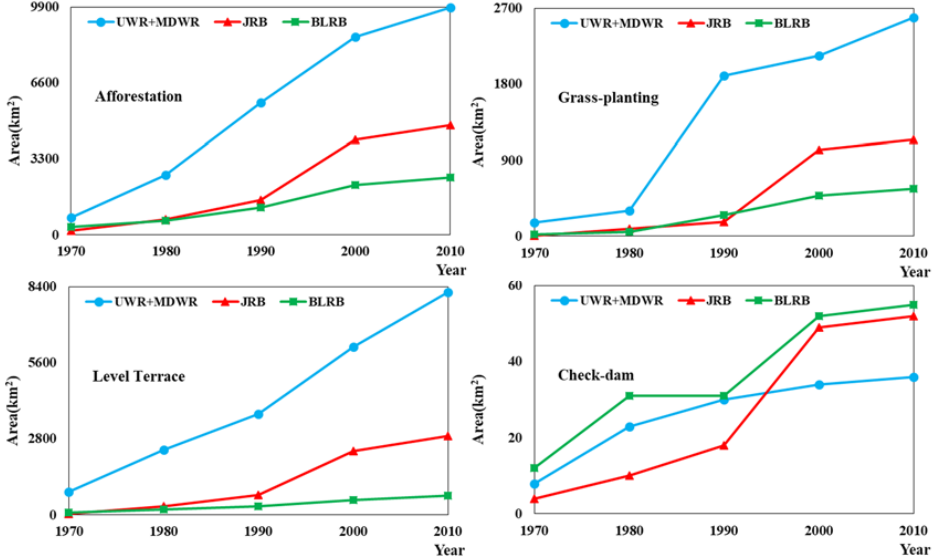
Figure 9. Statistics of soil and water conservation practices. Table 4. The percentage contribution of soil and water conservation measures and water users to the streamflow reduction caused by direct human activities at the end of each decade (%).